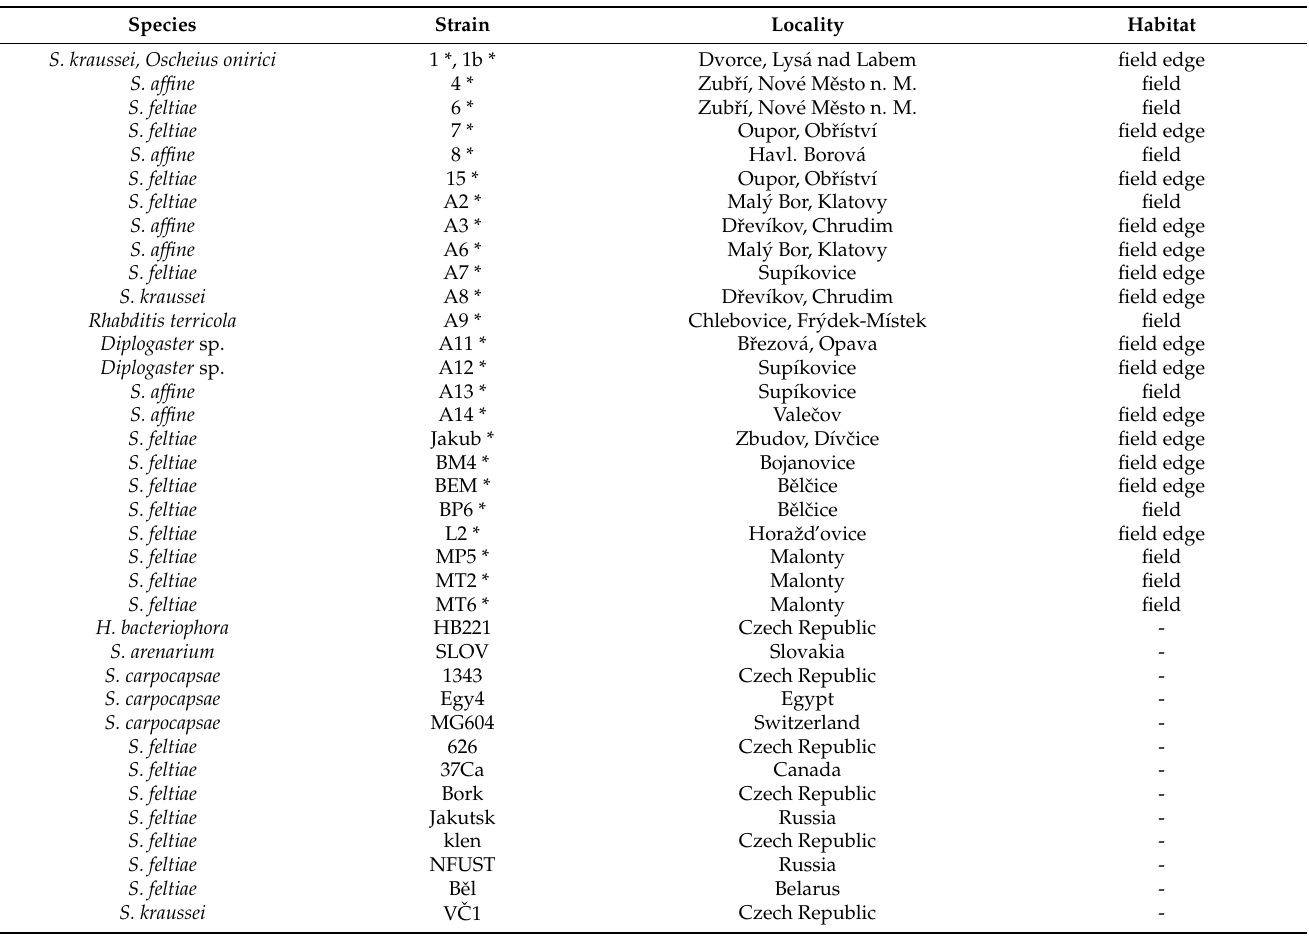
Table 1. Entomopathogenic nematodes used in different experiments. Marked strains (*) were isolated within this study, other strains originate in the laboratory collection.